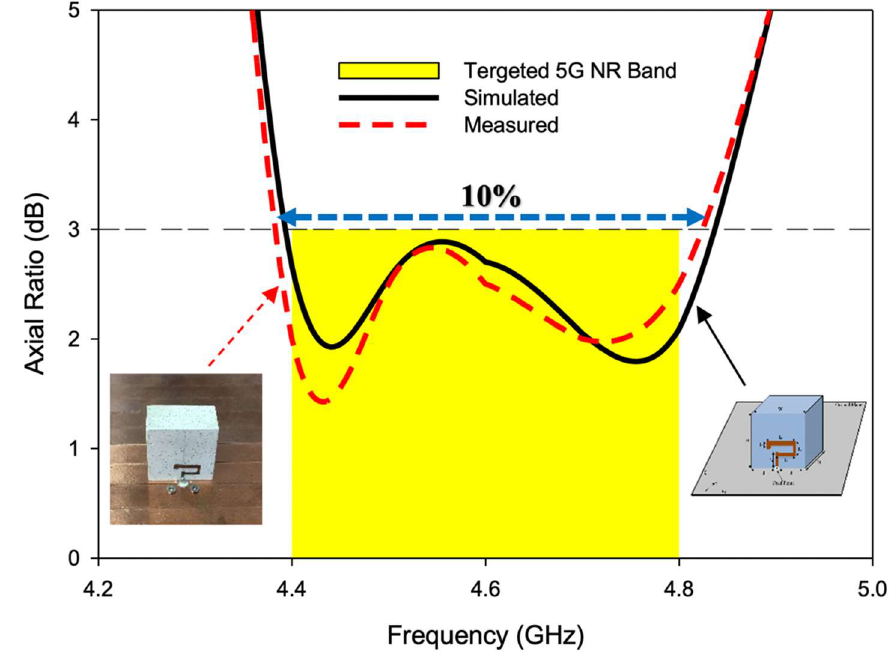
Figure 12. Simulated and measured S11 of the CP 5G RDRA.